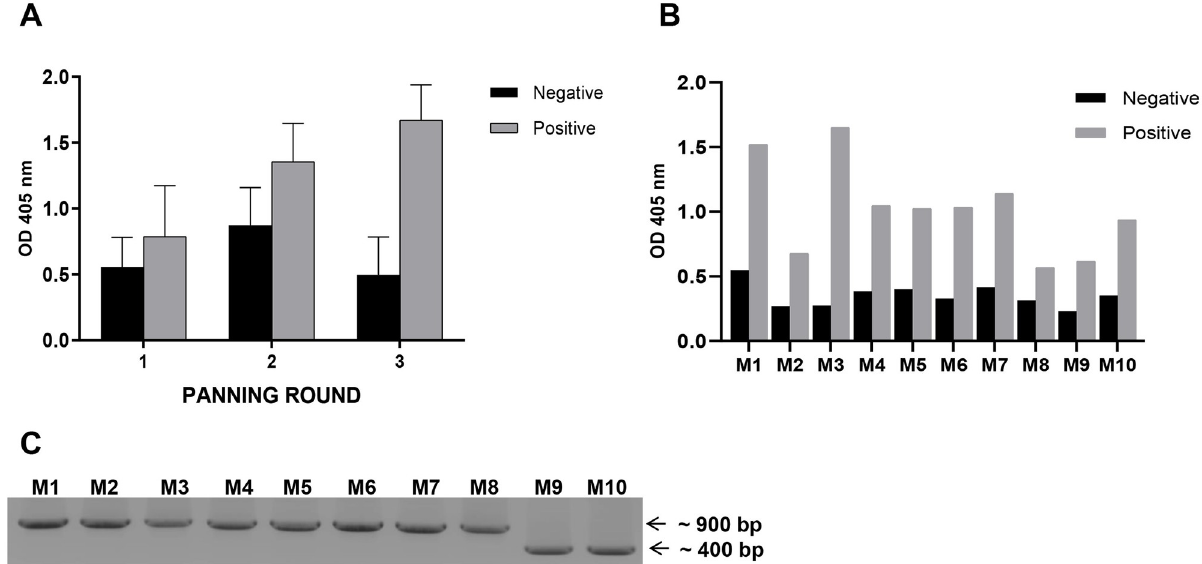
Fig 2. M2 specific candidates isolation using bio-panning. (A) Three rounds of bio-panning were performed with positive samples, in which M2 antigens were displayed on the yeast cell surfaces (M2::YSD), and negative samples (EBY100). Numerous phagemid colonies were randomly selected and the binding affinity measured for both positive and negative samples in each bio-panning round using Phage ELISA. Data are expressed as means ± SD. (B) Ten candidates with the highest binding affinity to M2::YSD were chosen using Phage ELISA from random phagemid colonies. (C) The 10 candidates, scFv and single-domain V L forms, were detected using PCR with specific primers (scFv at 900 bp and V L at 400 bp).